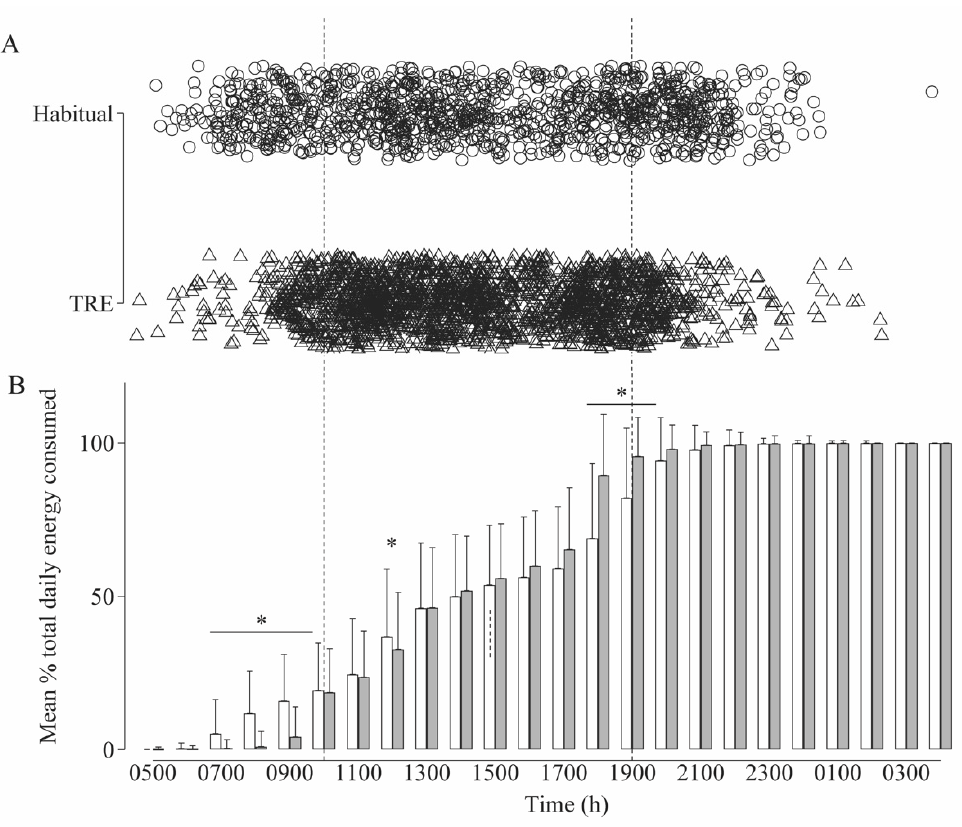
Figure 3. ( A ) Time of eating occasions during Habitual ( ○ n = 1089; 2 weeks) and time-restricted eating (TRE; △ n = 2051; 4 weeks) periods and ( B ) mean ± SD energy accumulation across the day during Habitual (unfilled bars) and TRE (filled bars). Significance ( p < 0.05) * between periods (Habitual vs. TRE) within time points, from linear mixed model analysis with Bonferroni post hoc tests.